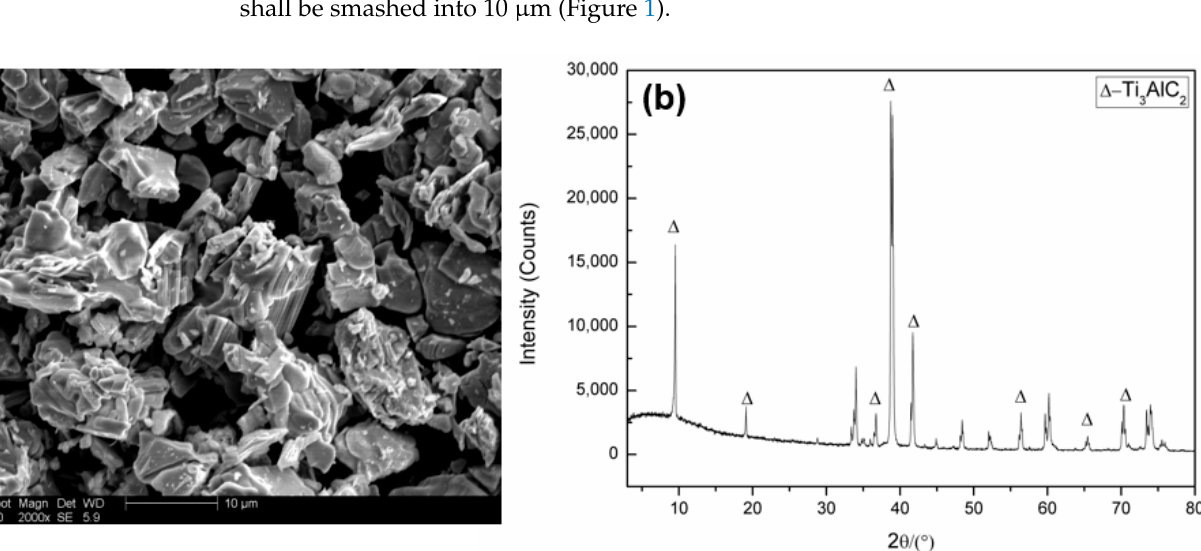
Table 1. Chemical compositions of the white cast iron.